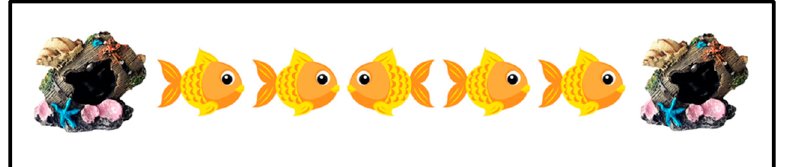
Figure 2. Example of the stimuli used in the Flanker test (incongruent condition).